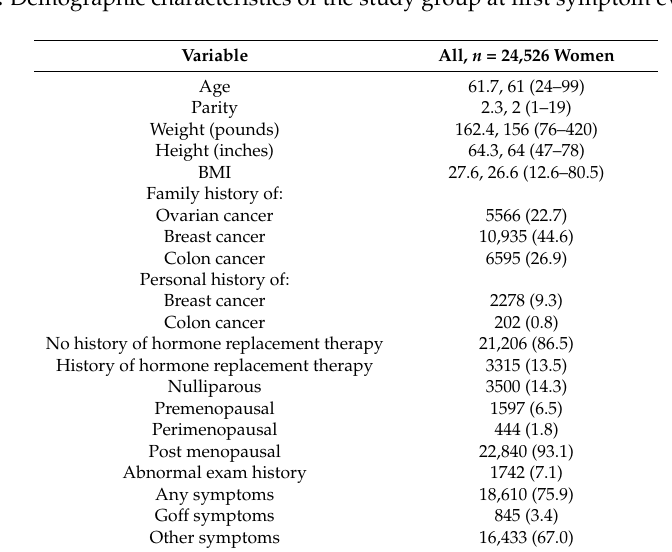
Table 1. Demographic characteristics of the study group at first symptom